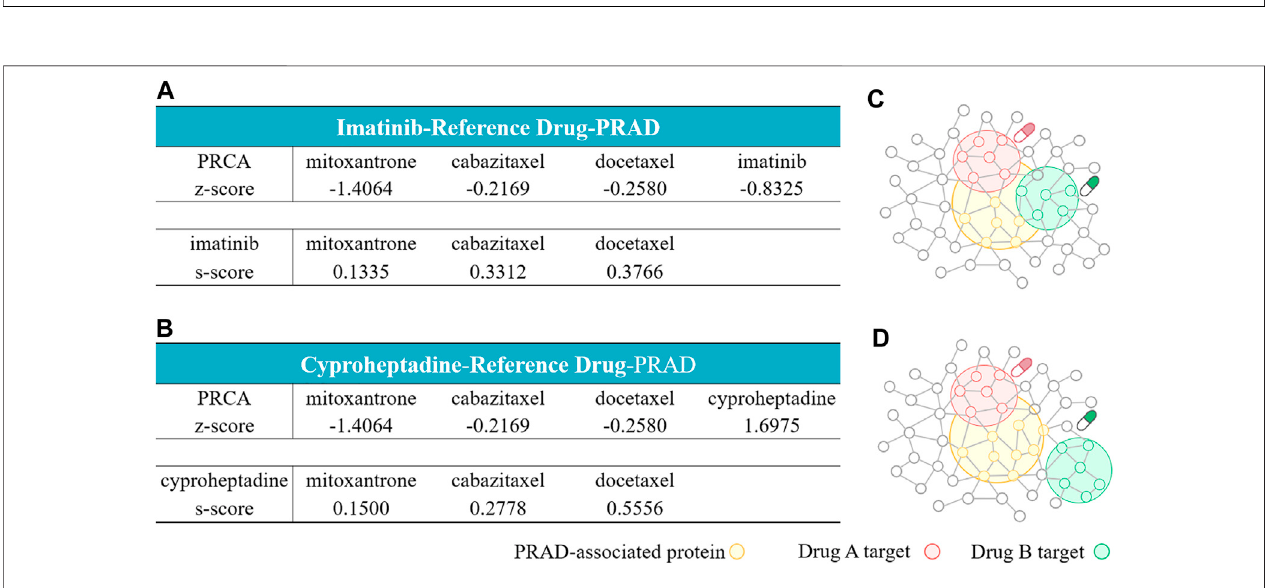
FIGURE 4 | Network con fi gurations of drug – drug – disease combinations. (A, B) The network-based relationship between two drug – target modules and one disease module on imatinib-reference drug- Prostate cancer (A) and cyproheptadine-reference drug-Prostate cancer (B) . (C, D) The exposure mode of the Prostate cancer-associated protein module to the pairwise drug combinations: the three imatinib-containing combinations (C) , and the three cyproheptadine-containing combinations (D) . The z-scores measure the drug – disease separation. The s-scores denote the topological relationship between two drug target modules.